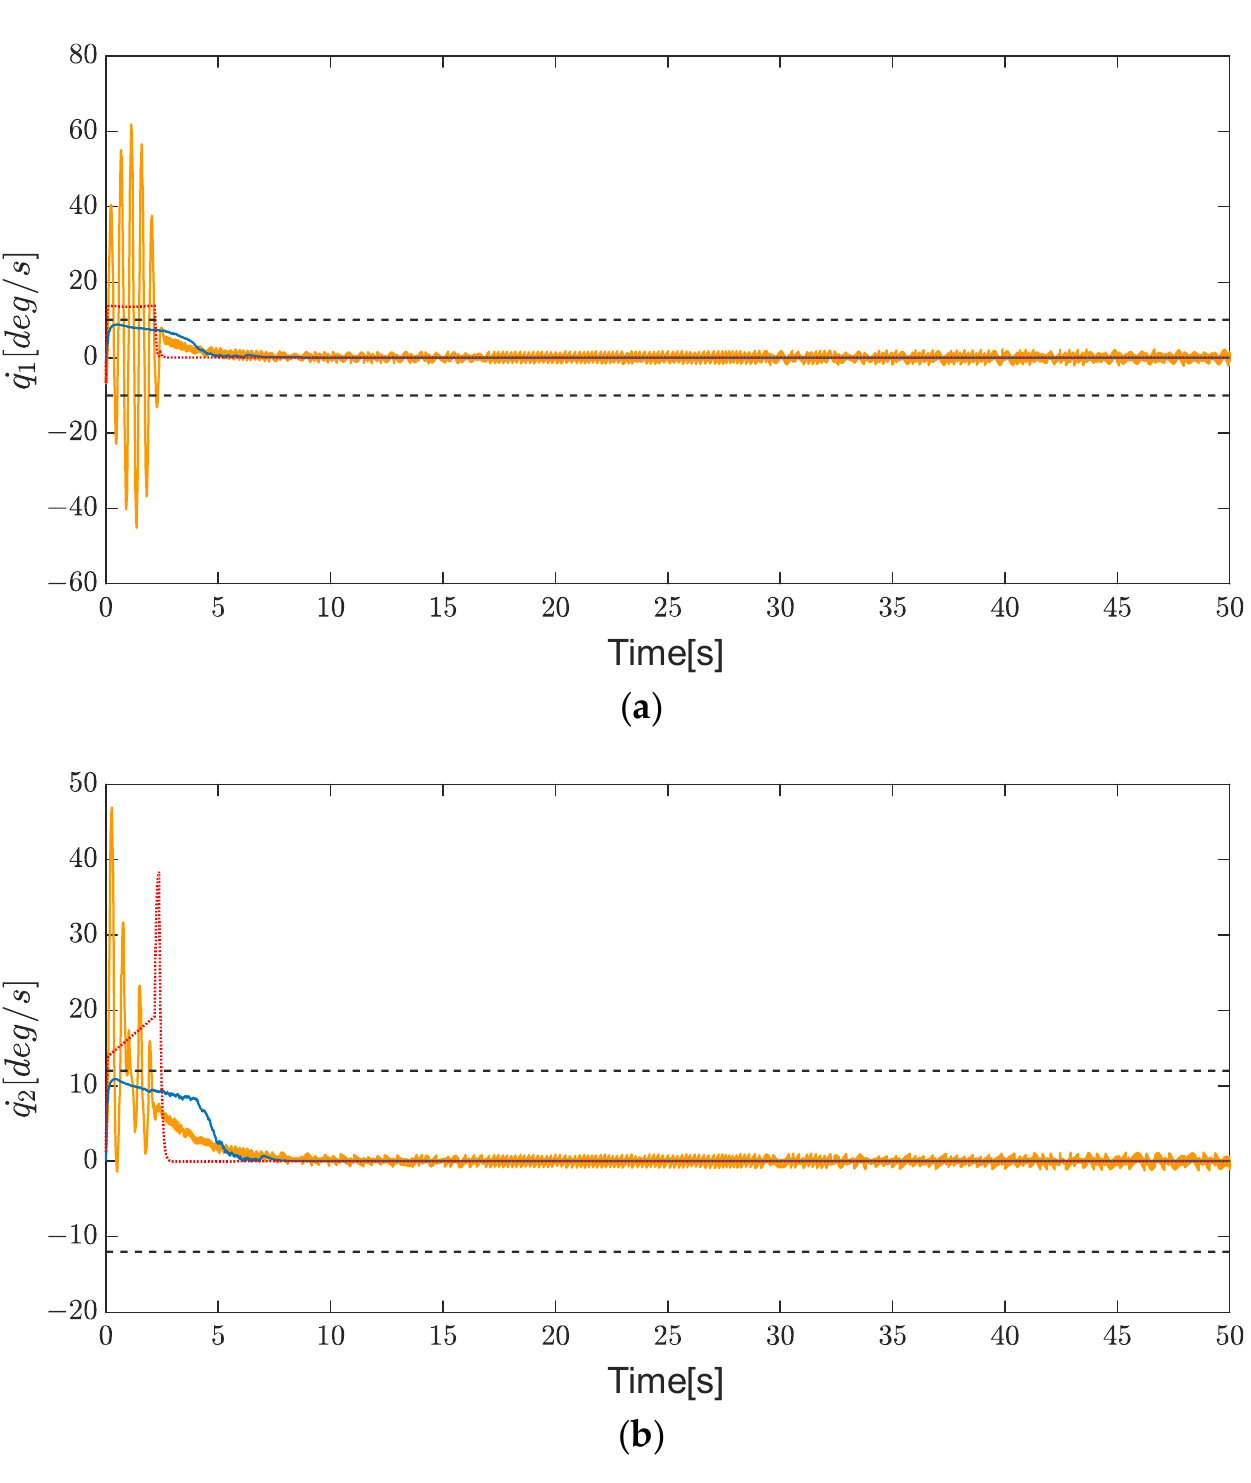
Figure 9. Comparison of angular velocity to [43,44] in case 1: [43] scheme (yellow solid line), [44] scheme (red dash line), the proposed scheme (blue solid line), the angular velocity constrains (black dashed line); ( a ) Joint 1. ( b ) Joint 2.